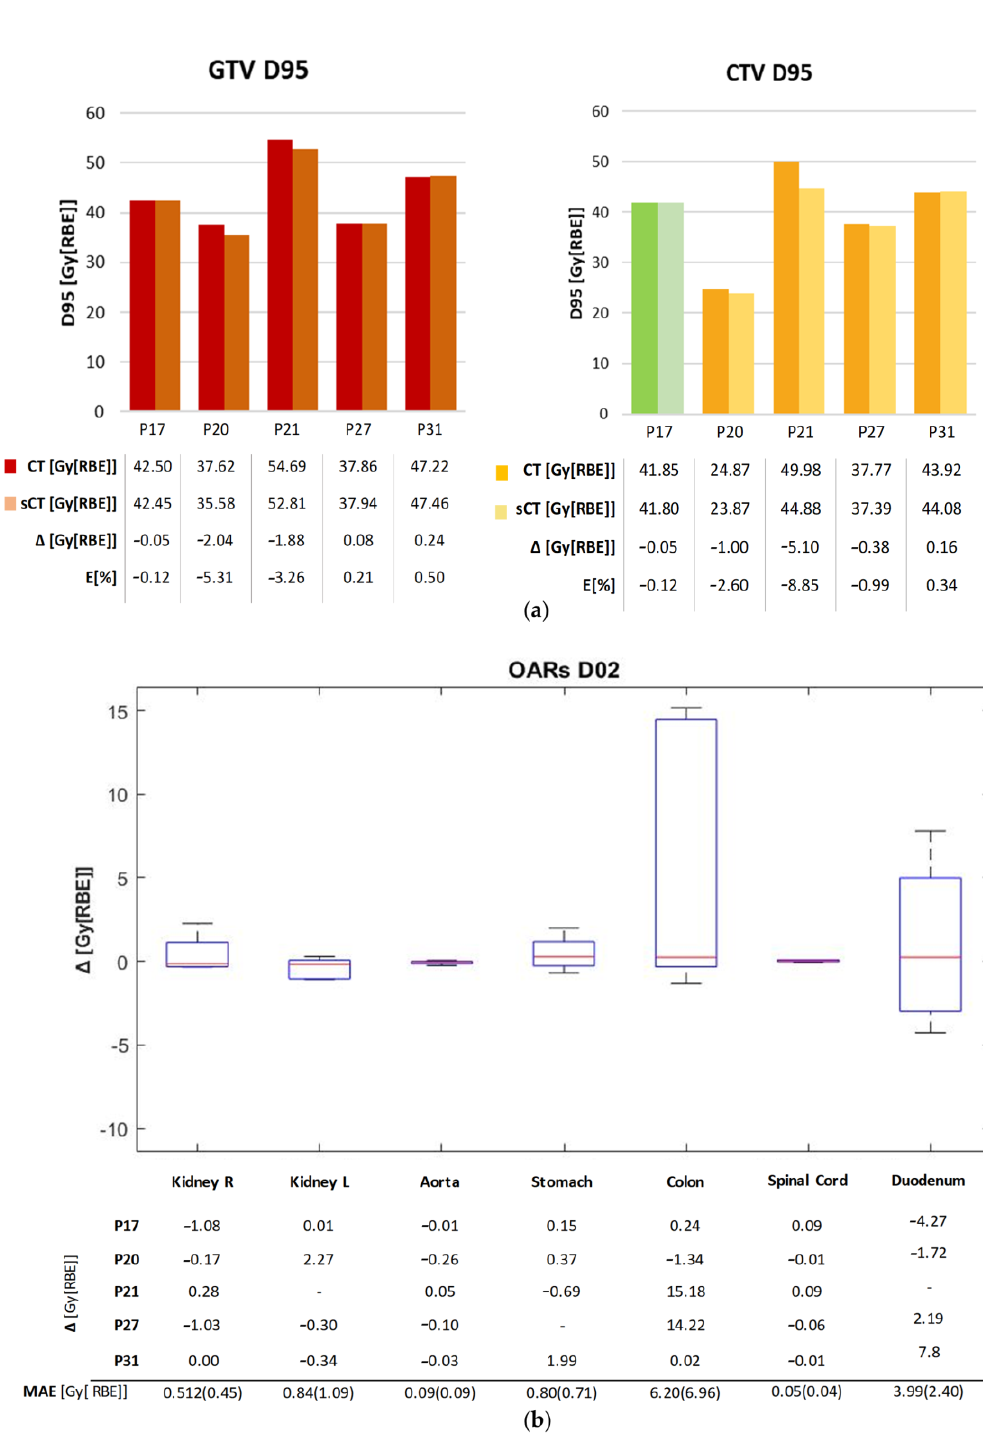
Figure 4. ( a ) D95% values for GTV and CTV in the original plan (CT) and the recalculated one (sCT). For P17, PTV was considered in this comparison (shown in Green). The table contains the dose values and the dose difference ∆ [Gy[RBE]], as well as the error relative to the prescribed dose E [%]. ( b ) D2% difference (sCT-CT) for the main OARs on each patient, and the D2% MAE over each OAR. The red mark indicates the median, and edges of the box show the 25th and 75th percentiles. Similarly, the values relative to the CTV showed the two dose distributions to have comparable results, with a maximum error of − 5.10 Gy[RBE] for P21 ( − 8.9% of the pre- scribed dose). The MAE on the D 95% CTV was 1.34 ± 1.33 Gy[RBE]. The D 2% relative errors on OARs lay in an interquartile range (IQR) of [ − 0.24,0.22]%, although the colon reached